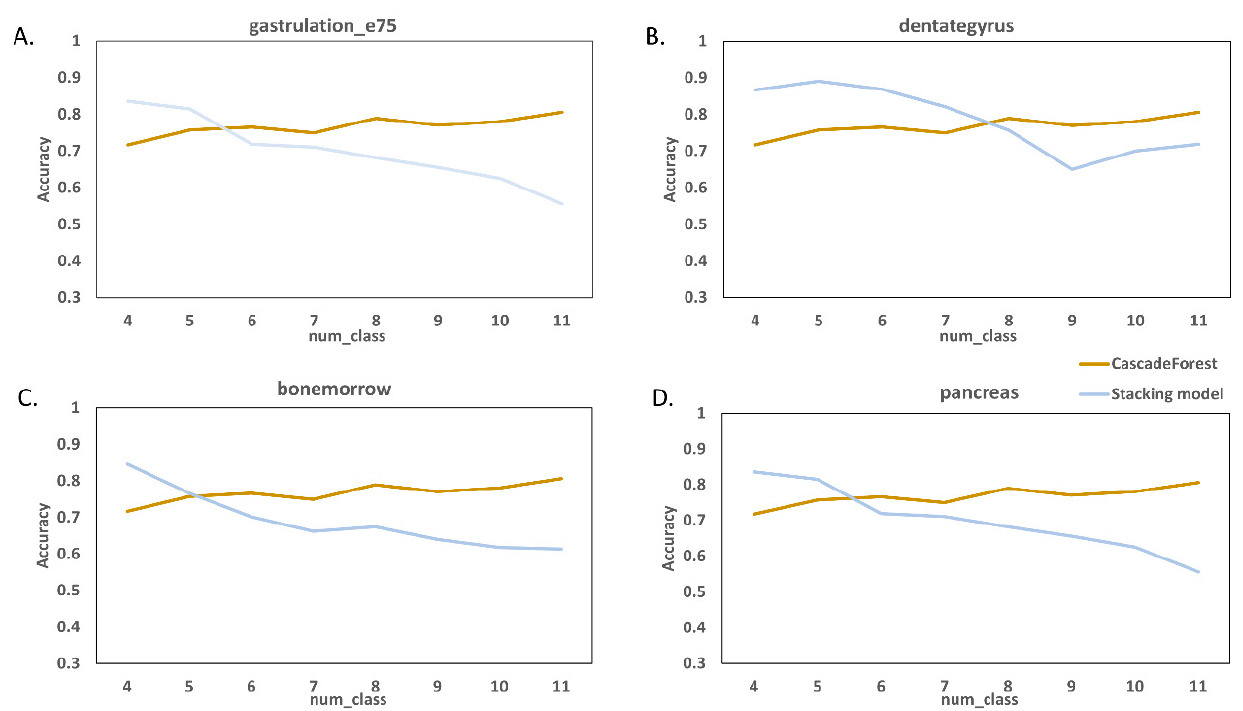
Figure 5. The effects of hyper-parameter d. ( A – D ) Performance of cascade forest models and stacking models under different datasets and different parameters d.